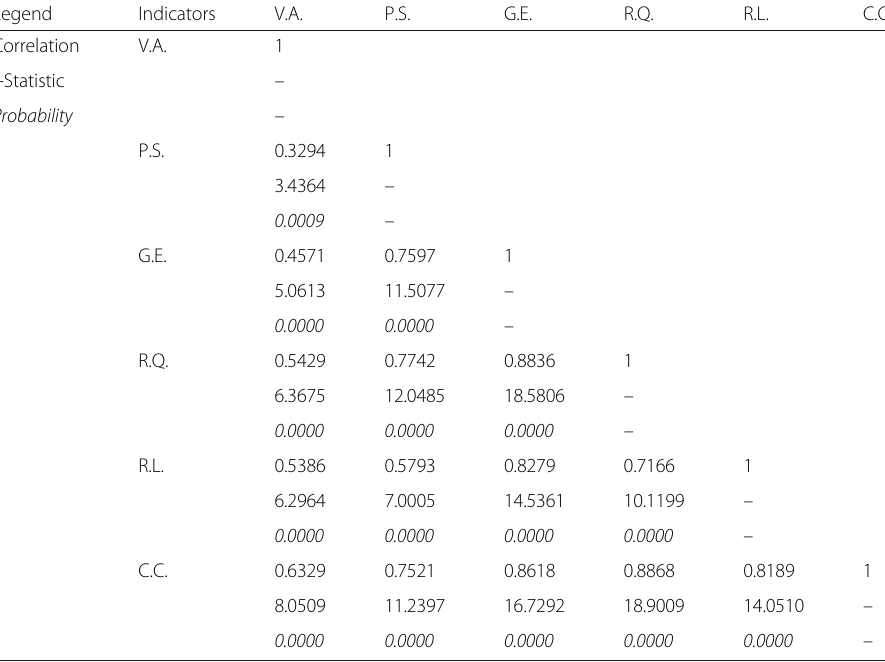
Table 3 Matrix of pair-wise correlation coefficients for institutional and governance indicators